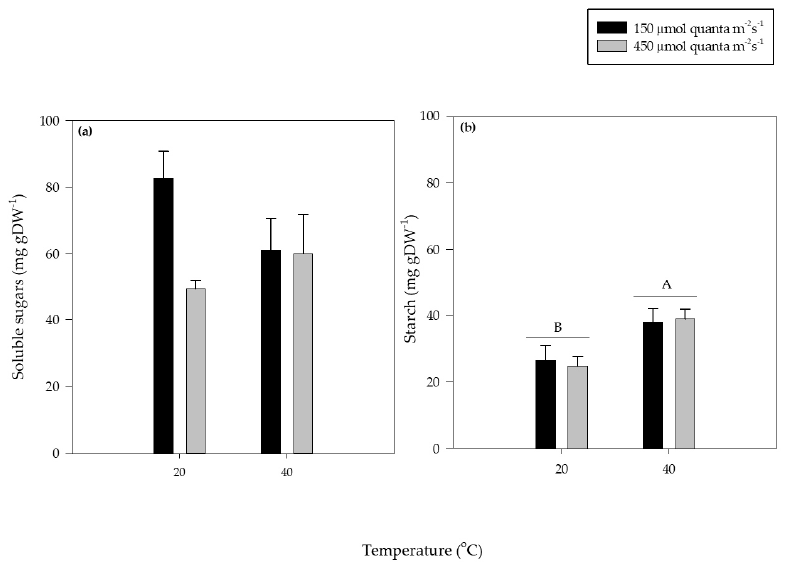
Figure 4. Effects of temperature and light on Cymodocea nodosa : ( a ) soluble sugars concentration and ( b ) starch concentration. Values represent mean ± SE ( n = 3). Different letters indicate significant differences among light levels under the same temperature ( p < 0.05, SNK test); * indicate significant differences among temperatures under the same light level ( p < 0.05, SNK test); capital letters indicate differences among temperature independently of light level (no interaction among factors; p < 0.05, SNK test).